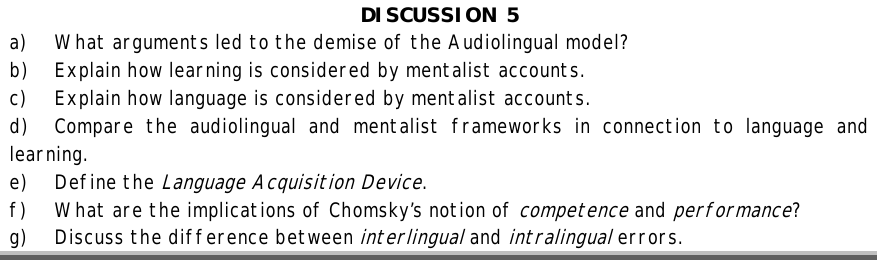
Table 1: Summary of theoretical background in Cognitive theory